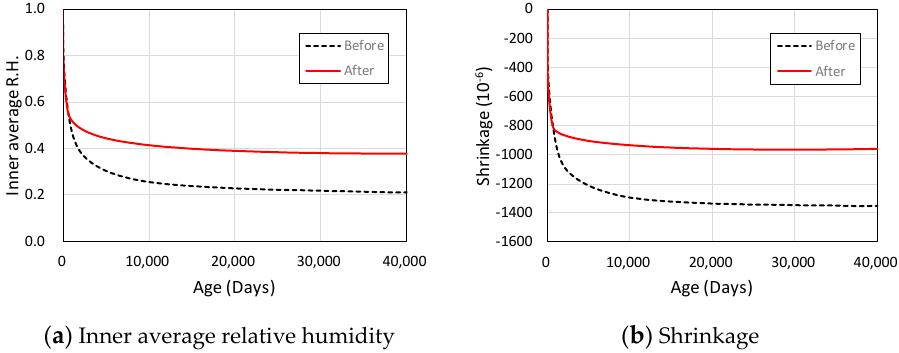
Figure 28. Comparison of inner average relative humidity and shrinkage between before and after the extensive modeling (W/C = 30%, OPC).